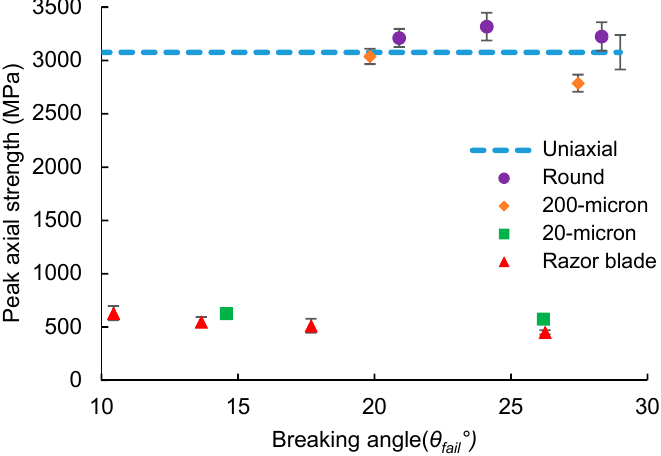
Figure 8. Representative axial stress vs. strain response at a starting of 25° for ( a ) Round projectile and 200-micron indenter and ( b ) 20-micron indenter and razor blade.